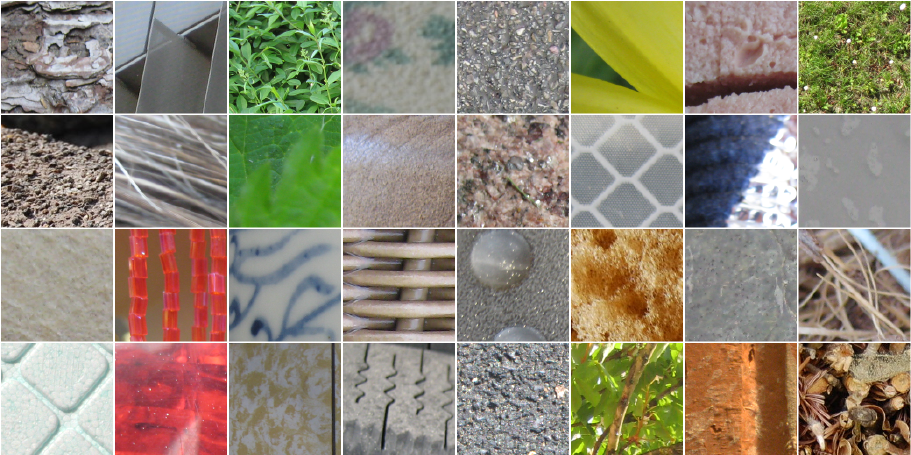
Figure 8. Samples of different categories from the Stex dataset among the 476 color texture classes.